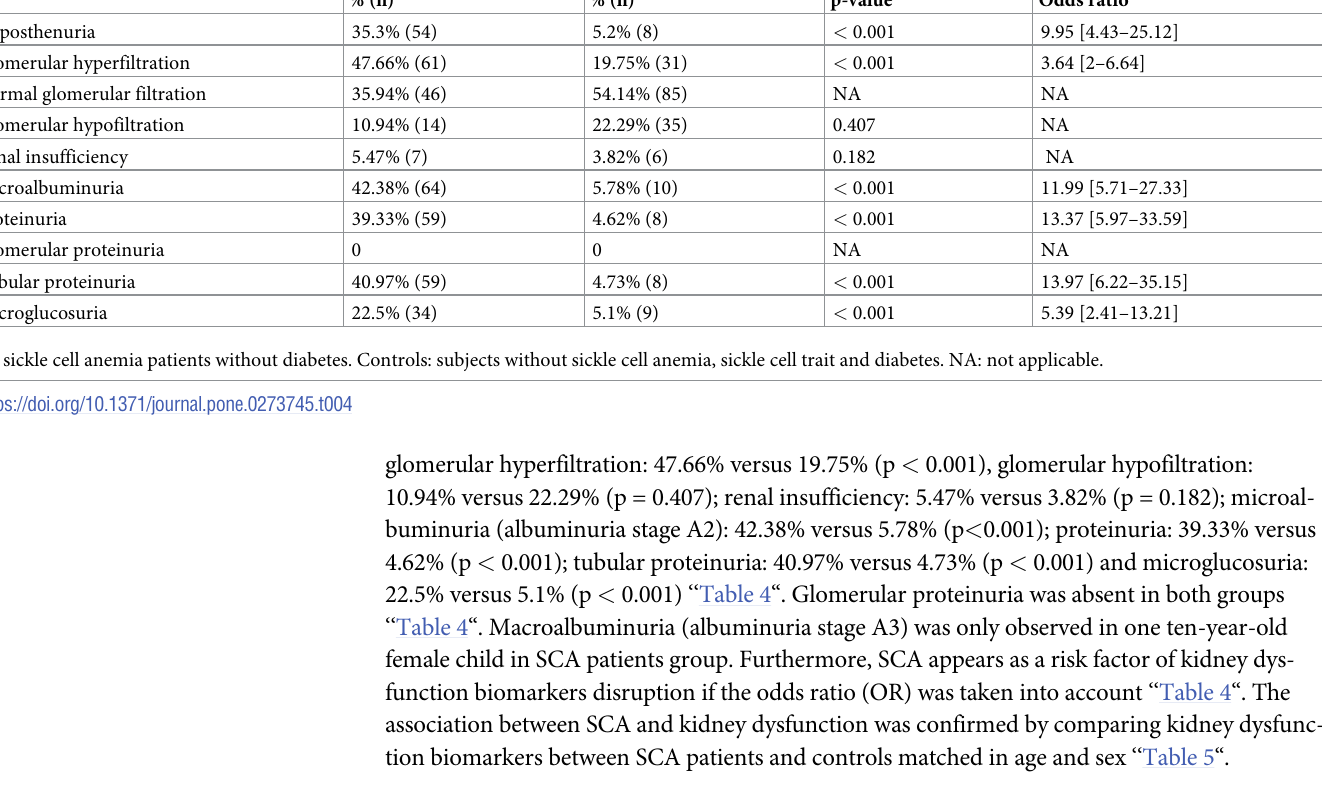
‘‘Table 4“. Macroalbuminuria (albuminuria stage A3) was only observed in one ten-year-old female child in SCA patients group. Furthermore, SCA appears as a risk factor of kidney dys- function biomarkers disruption if the odds ratio (OR) was taken into account ‘‘Table 4“. The association between SCA and kidney dysfunction was confirmed by comparing kidney dysfunc- tion biomarkers between SCA patients and controls matched in age and sex ‘‘Table 5“.